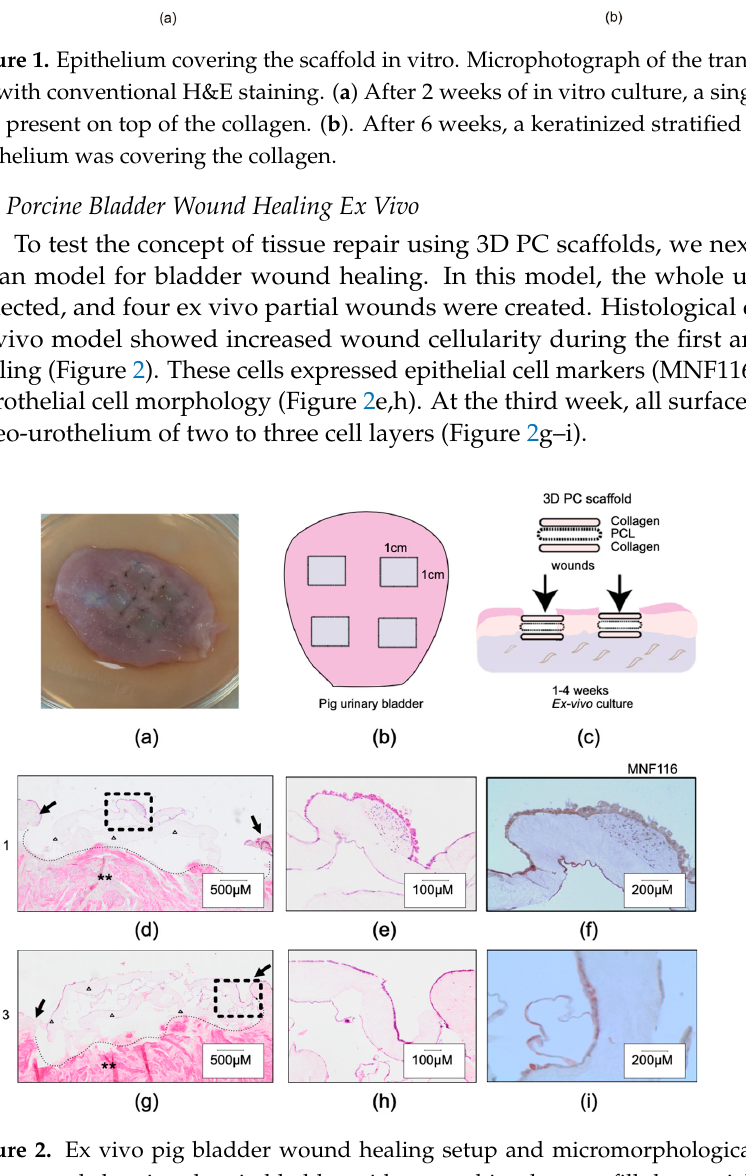
Figure 2. Ex vivo pig bladder wound healing setup and micromorphological findings. ( a ) Left upper panel showing the pig bladder with sutured implants to fill the partial thickness wounds. ( b , c )